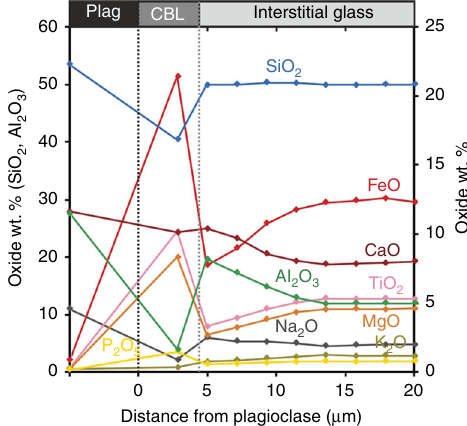
Fig. 2 Micron-scale compositional changes across an Fe-rich compositional boundary layer (CBL). A micron-scale compositional transect obtained using EMPA through Si-rich glass adjacent to an Fe-rich CBL. Sample from the crust of the K ī lauea Iki lava lake (quench temperature of 1112 °C), sampled by the 1976 drill core at 45.5 m. Note the two different scales